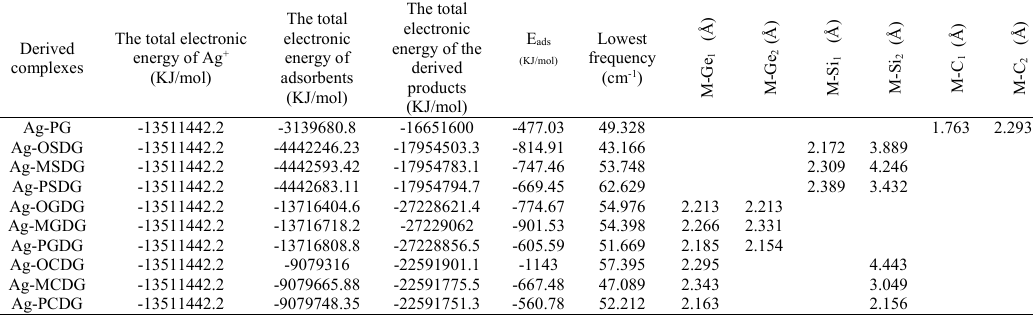
Table 1. Adsorption energy values, lowest frequency and bond lengths for the Ag + adsorption process The total The total electronic The total electronic electronic Derived energy of the energy of Ag + energy of complexes derived (KJ/mol) adsorbents products (KJ/mol) (KJ/mol) Ag-PG